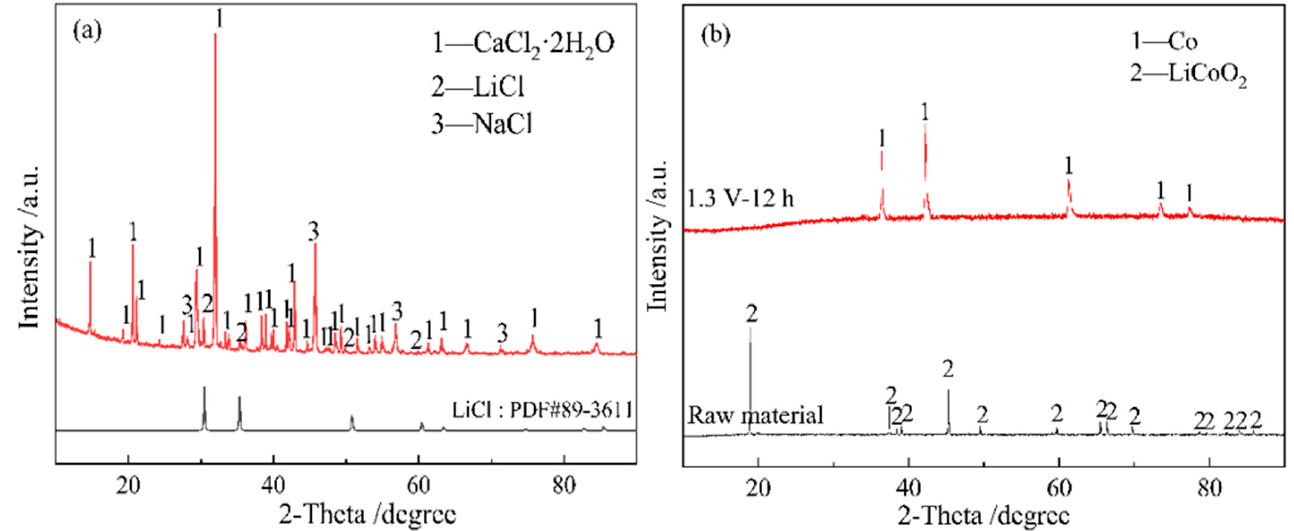
Figure 2. The XRD pattern of the electrolysis product of LiCoO 2 in CaCl 2 –NaCl molten salt at 750 °C and the molten salt near the electrode: ( a ) molten salt near the cathode after electrolysis; ( b ) LiCoO 2 electrolysis product.